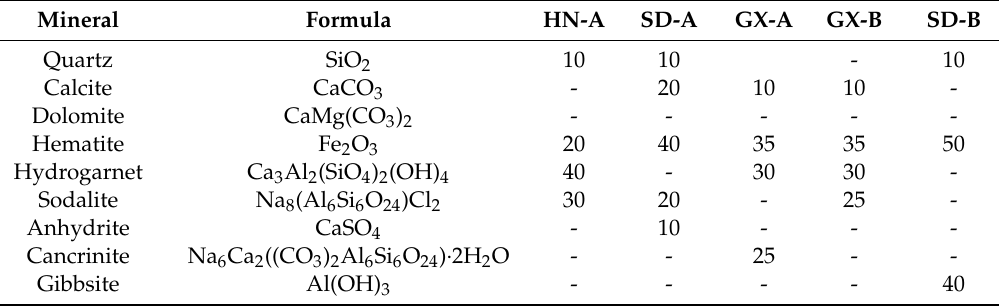
Table 4. The mineral compositions (wt.%) of red mud sampled in this